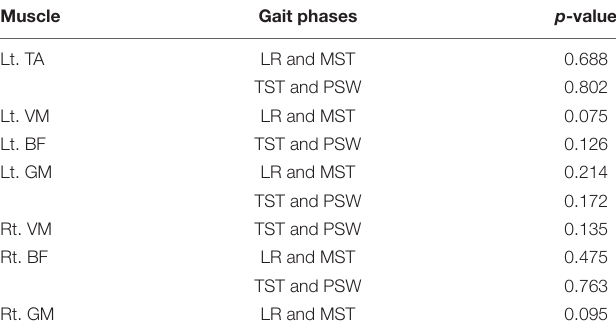
TABLE 1 | Multiple comparison results of the seven gait phases for the beta band. Muscle Gait phases p -value Lt.